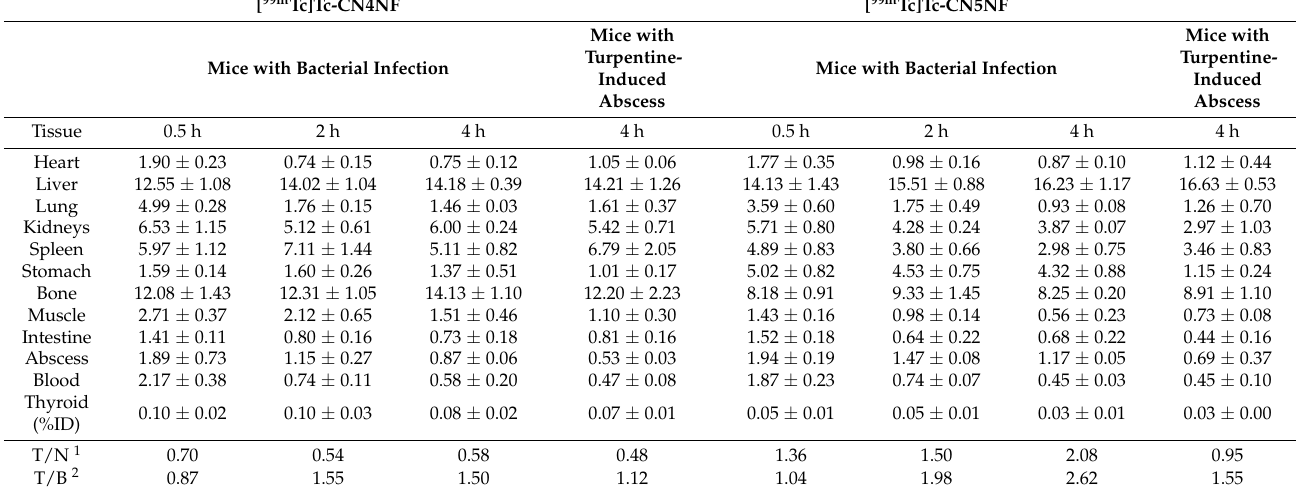
Mice with Turpentine- Induced Ab- scess